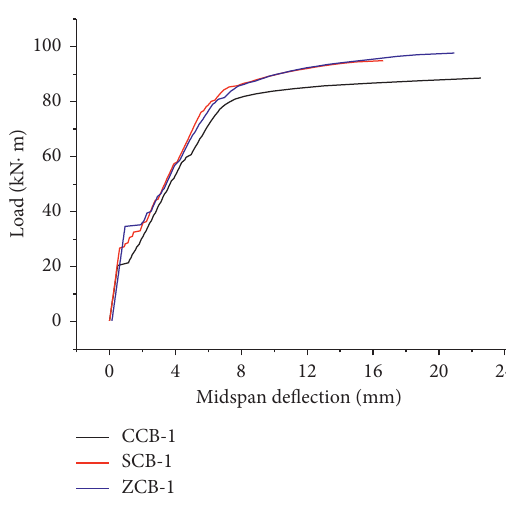
Figure 25: Load-displacement curves.